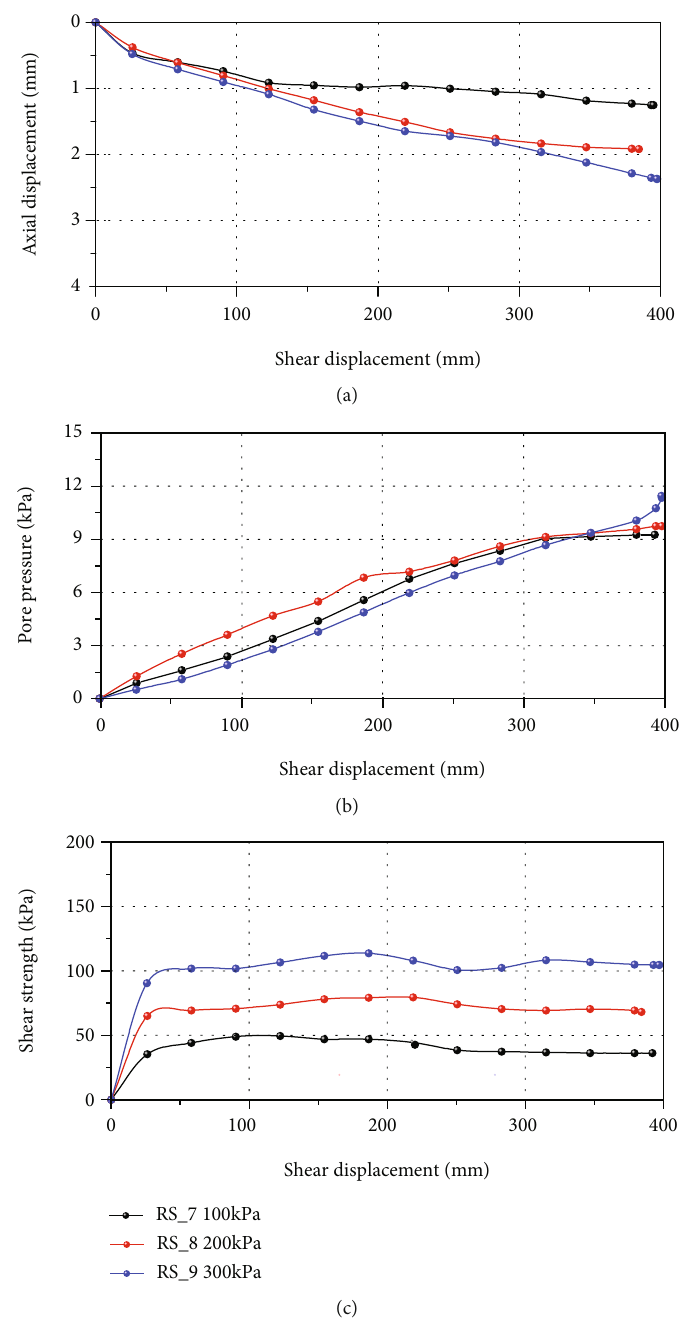
Figure 5: Results of ring shear tests with a shearing rate of